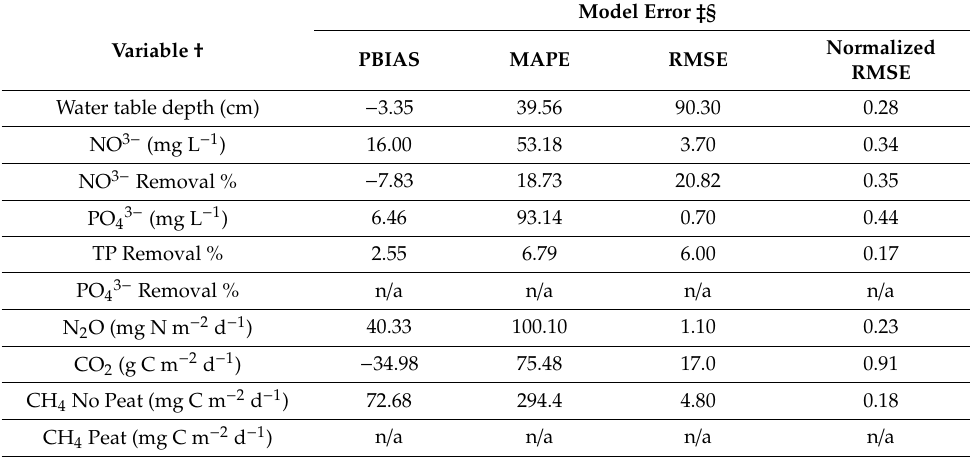
† : See Table 5 for acronym definition in the “variable” column. ‡ : PBIAS = percent bias; MAPE = mean absolute percent error; RMSE = root mean square error. §: n / a = see definition in Table 5. ¶: normalized RMSE = root mean square normalized by the range; n / a = not